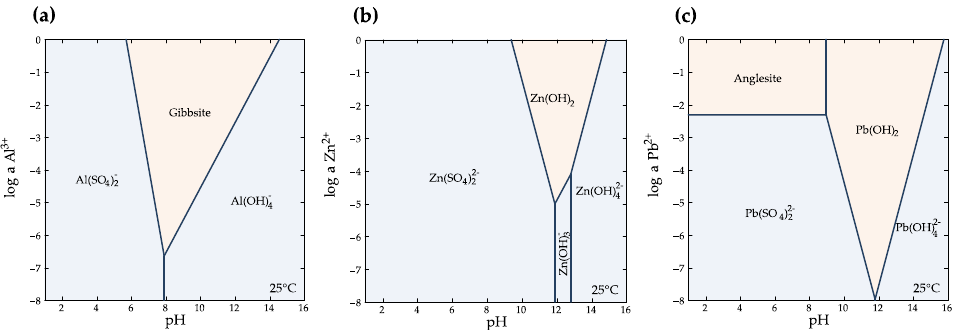
Figure 3. Log activity-pH predominant diagram for ( a ) 0.1 mM Al 3+ and 0.1 mM SO 42 − , ( b ) 0.1 mM Zn 2+ and 0.1 mM SO 42 − , and ( c ) 0.1 mM Pb 2+ and 0.1 mM SO 42 − at 25 ◦ C and 1.013 bar created using the Geochemist’s Workbench ® with MINTEQ database [39] (for interpretation of the references to color in this figure legend, the reader is referred to the web version of this